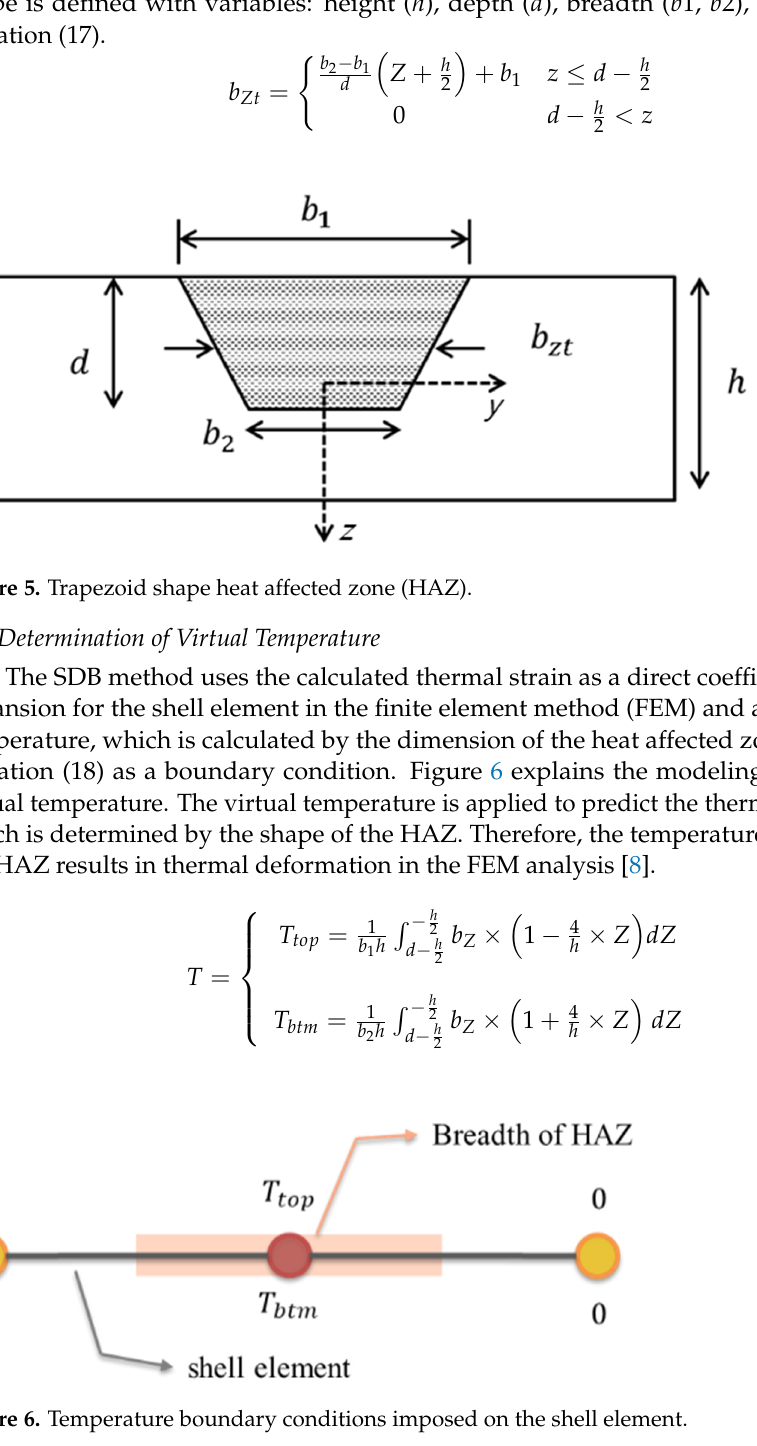
Figure 7. Virtual temperature for irregular mesh. 4. Application of Method 4.1. Problem Description The proposed methods were applied to an 18 mm thick steel curved plate with a curvature of 1/1500mm. The dimensions are length: 3000mm and width: 1500mm. A- grade mild steel was applied. As shown in Figure 8, the HAZ dimension was measured to define the shape variables. The 𝑏 (cid:2869) , 𝑏 (cid:2870) , and 𝑑 are 14 mm, 8 mm, and 0.6 mm, respec- tively, and the heating lines are 15ea, as shown in Figure 9. The heat source moving speed is 3mm/sec and sequentially heated from the left line.